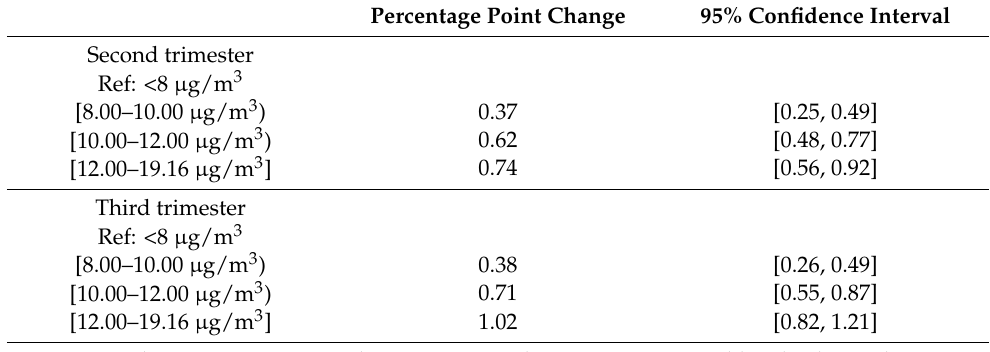
Panel B: Direct association between prenatal PM 2.5 exposure and low birth weight